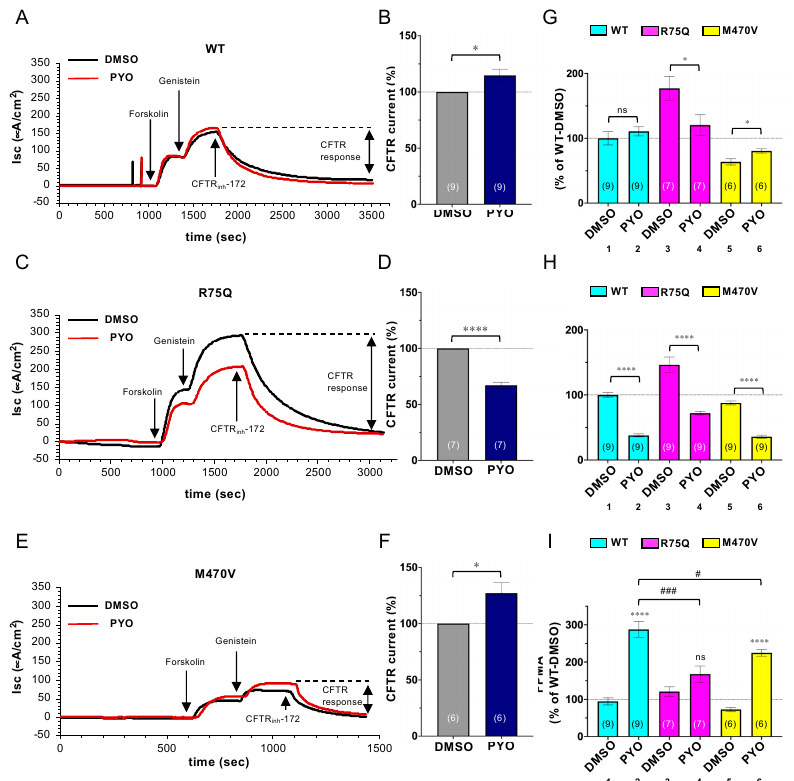
Figure 6. Effect of PYO on the Cl − channel function of WT-, R75Q- or M470V-CFTR. ( A – F ) Apical CFTR current (Isc) in CFBE Tet-on cells expressing WT- ( A , B ), R75Q- ( C , D ), or M470V-CFTR ( E , F ) treated with Dox (50 ng/ml) for 3 days was measured after sequential addition of 10 µM for- skolin and 100 µM genistein, followed by CFTR inhibition with 20 µM CFTRinh-172. PYO (5 µM) was treated for 2 days before Isc measurement. The effect of PYO on the WT- ( B ), R75Q- ( D ), and M470V-CFTR ( F ) Isc was calculated and expressed as % of the Isc in each DMSO-treated cell. ( G ) The Isc of CFTR variants was compared and expressed as % of the WT-CFTR Isc in the DMSO- treated cells. ( H ) The PM density of CFTR variants in CFBE Tet-on cells treated under the same condition as in G, except for Dox (1 µg/ml), was measured by cell surface ELISA. ( I ) The FPMA of CFTR variants was calculated as the ratio of the Isc ( G ) to PM density (H) and normalized to WT- CFTR in the DMSO-treated cells. Data represent mean±SE. The number of data from at least two independent experiments is indicated in parentheses. n.s., not significant; * p < 0.05, **** p < 0.0001 ( t -test). # p < 0.05, ### p < 0.001 (one-way ANOVA).